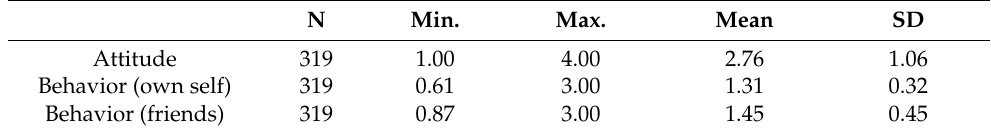
Table 1. Students’ attitudes and behavior towards academic dishonesty. N Min.